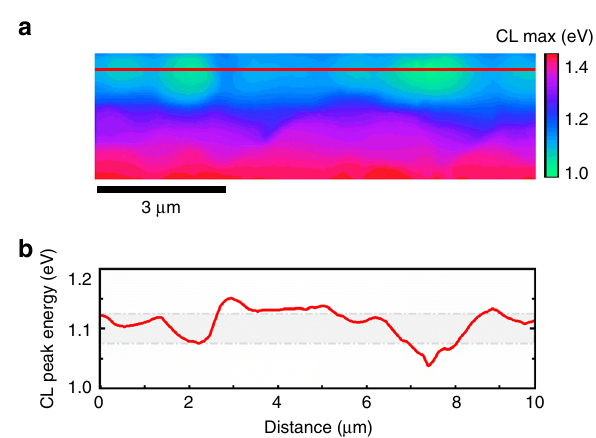
Fig. 4 Evaluation of cathodoluminescence peak energy. a CL peak energy distribution map, from the identical cross-section area as in Fig. 3, and b extracted pro fi le (red line in a ) reveals band-gap energy fl uctuations with a standard deviation (gray area) of <25 meV near the interface to the CdS buffer layer.